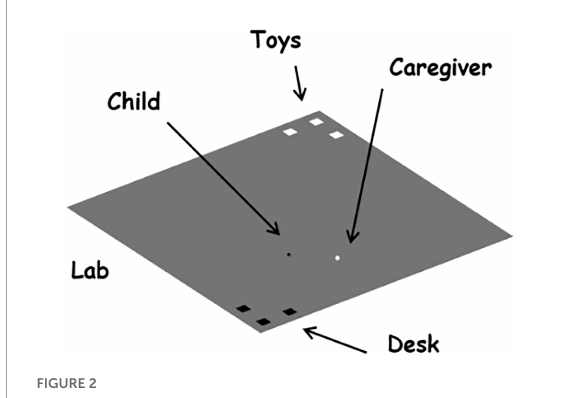
FIGURE2 The agents and the simulation environment. The lab (simulation environment) resembles a large square room, where a child (black dot) and a caregiver (white dot) are free to move. The lab has some objects of interest for the child (white squares at the top corner; e.g., toys) and some objects of interest for the caregiver (black squares at the bottom corner; e.g., a